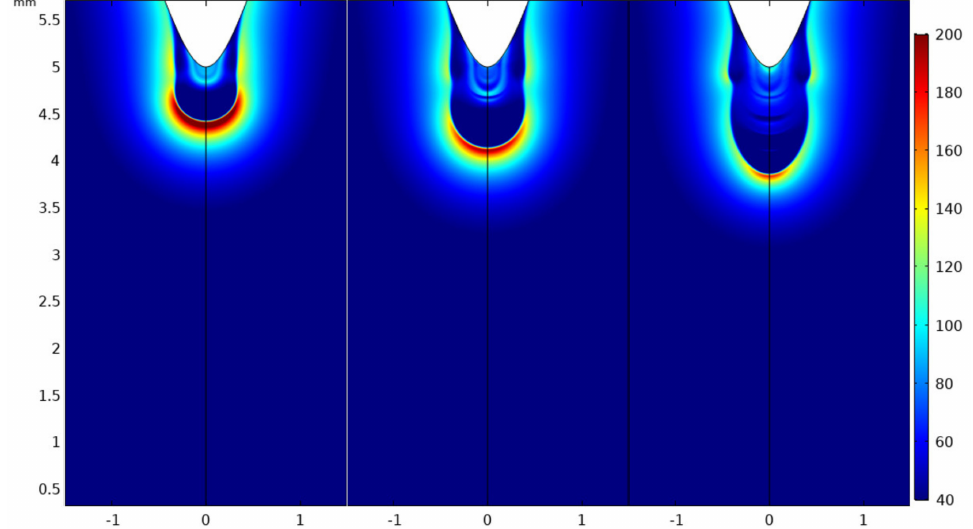
Figure 9. Surface plot of electric field distribution (kV/cm) corresponding to the electron density profile in Figure